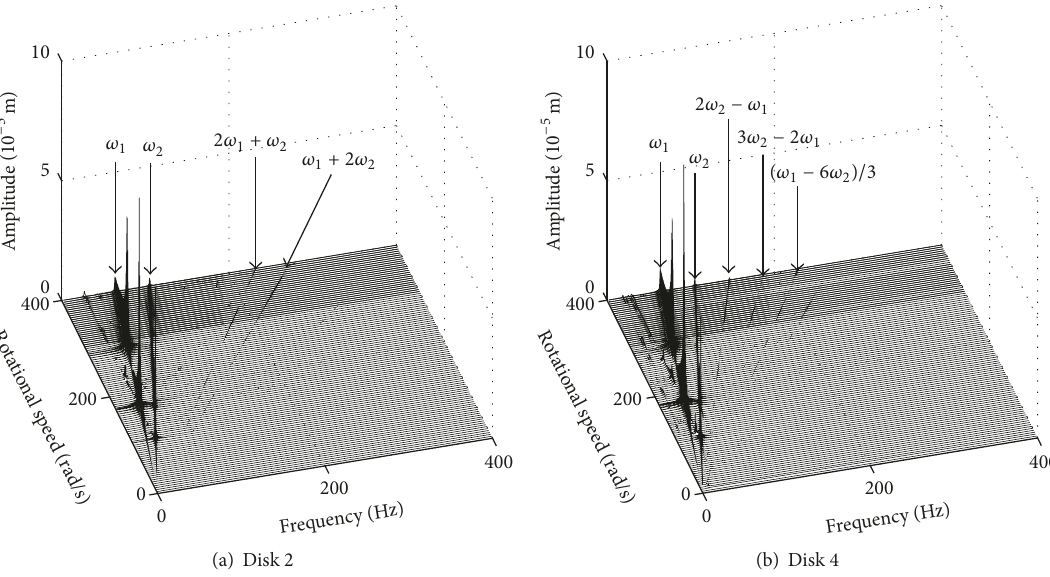
Figure 5: Spectrum cascade of the horizontal response of disks 2 and 4, numerical simulation. 𝜆 = 1.65 .